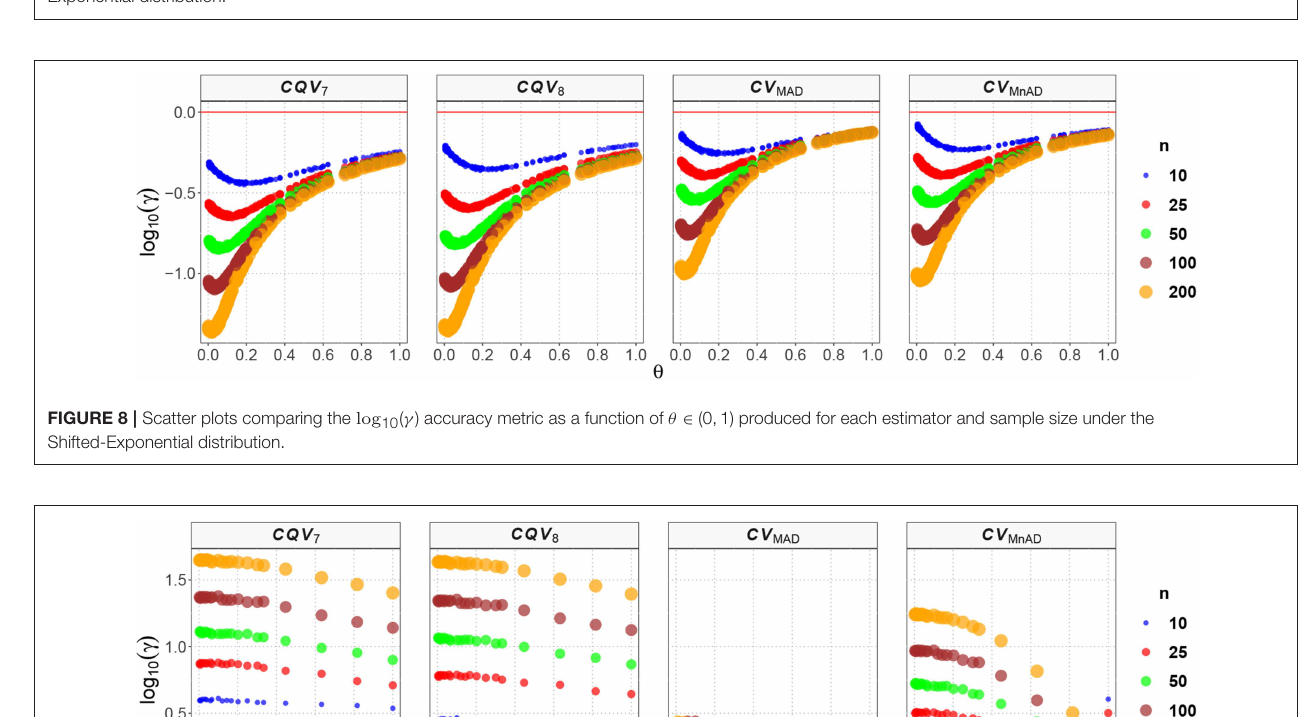
FIGURE 9 | Scatter plots comparing the log 10 ( γ ) accuracy metric as a function of θ Chi-square distribution.